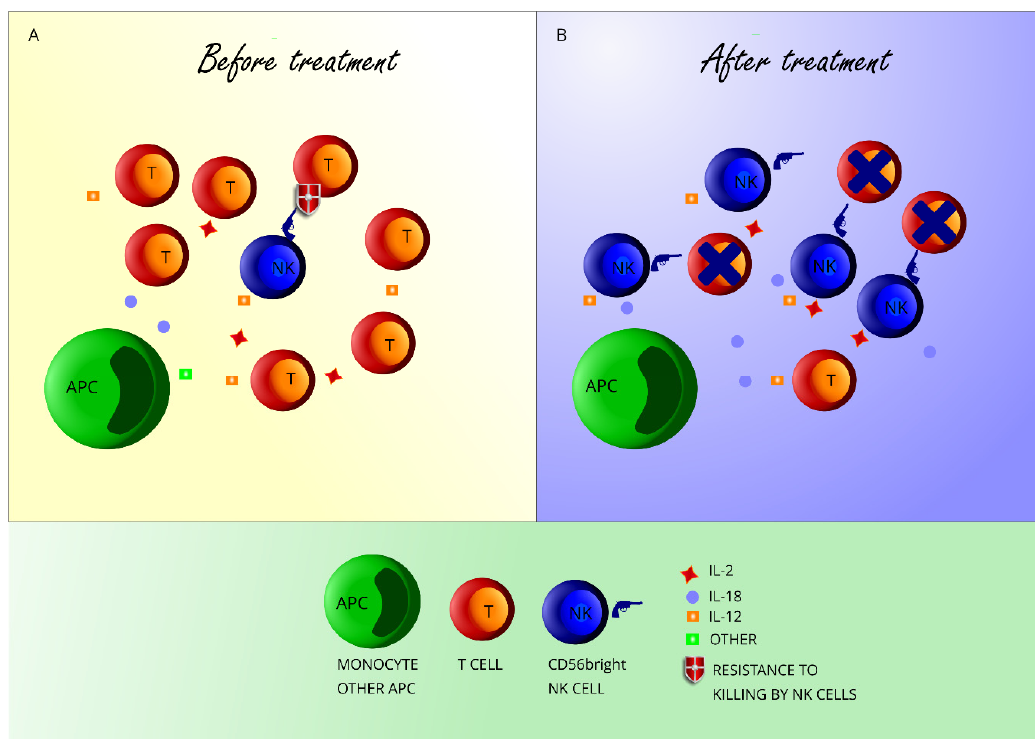
Figure 1. CD56 bright NK cell expansion after DMT in multiple sclerosis (MS). Panel A: Before treatment, antigen-presenting cells (APC) secrete cytokines that activate T-cells and CD56 bright NK cells. T-cells outnumber CD56 bright NK cells and are resistant to killing by CD56 bright NK cells through various mechanisms. Panel B: DMTs decrease T-cell numbers, leading to the increased availability of cytokines secreted by APC (such as IL-18 and IL-12) and by T-cells themselves (IL-2) to CD56 bright NK cells. Some treatments may restore the killing of T-cells by CD56 bright NK cells. Some treatments might also induce higher secretion of cytokines by APC.